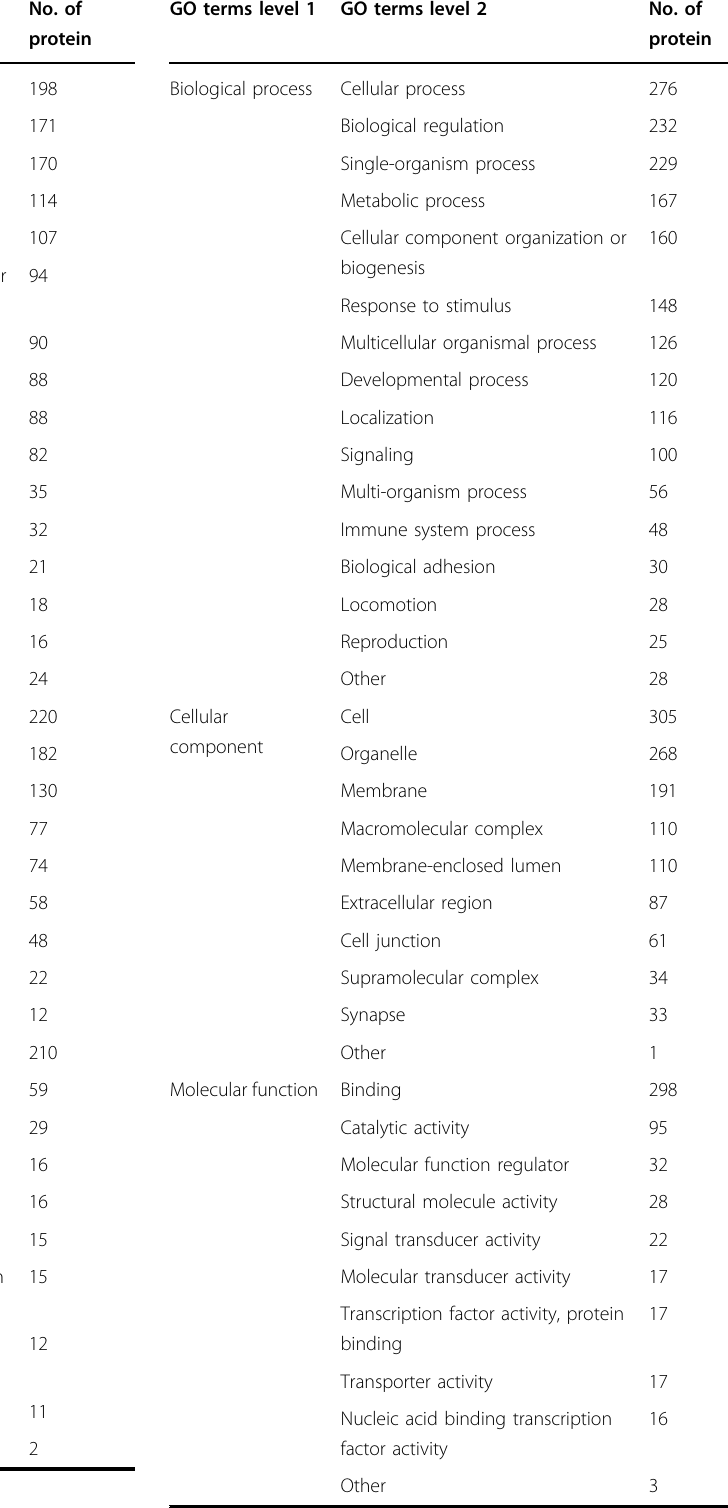
Table 1 GO secondary annotations of proteins with upregulated p-site (WT vs. OE-GOLM1).